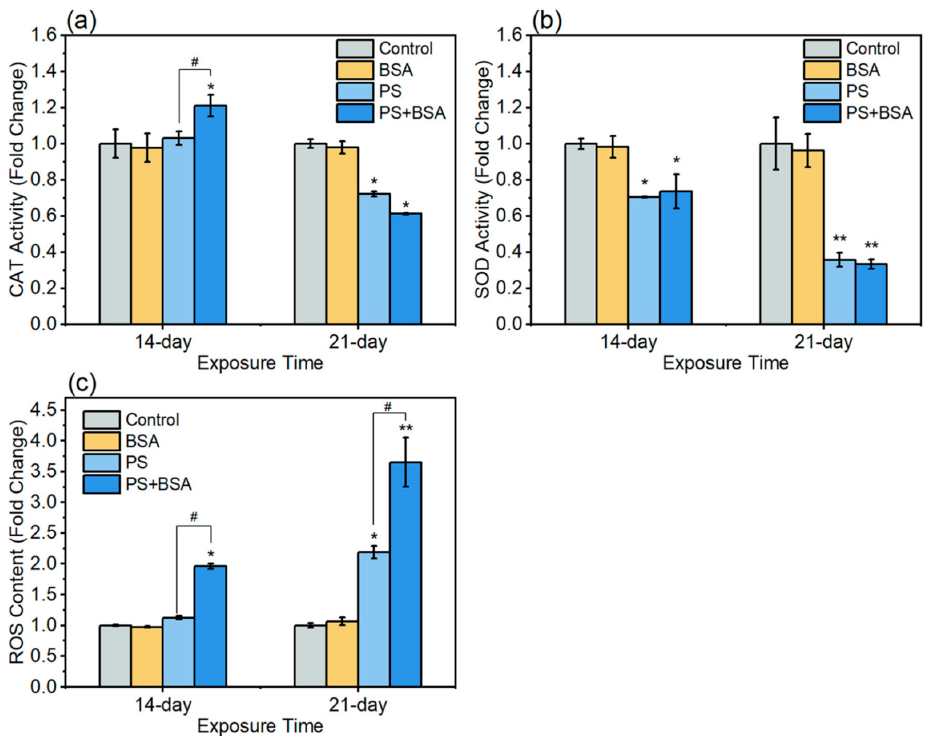
Figure 9. CAT activity ( a ), SOD activity ( b ), and ROS content ( c ) in zebrafish intestines after 14- and 21-day exposures to BSA, PS, or PS + BSA. * p < 0.05 and ** p < 0.01 indicate significant differences between the treatment groups and the control group. # p < 0.05 indicates significant differences between the two groups indicated. Figure reproduced from Luo et al. [74] with permission.